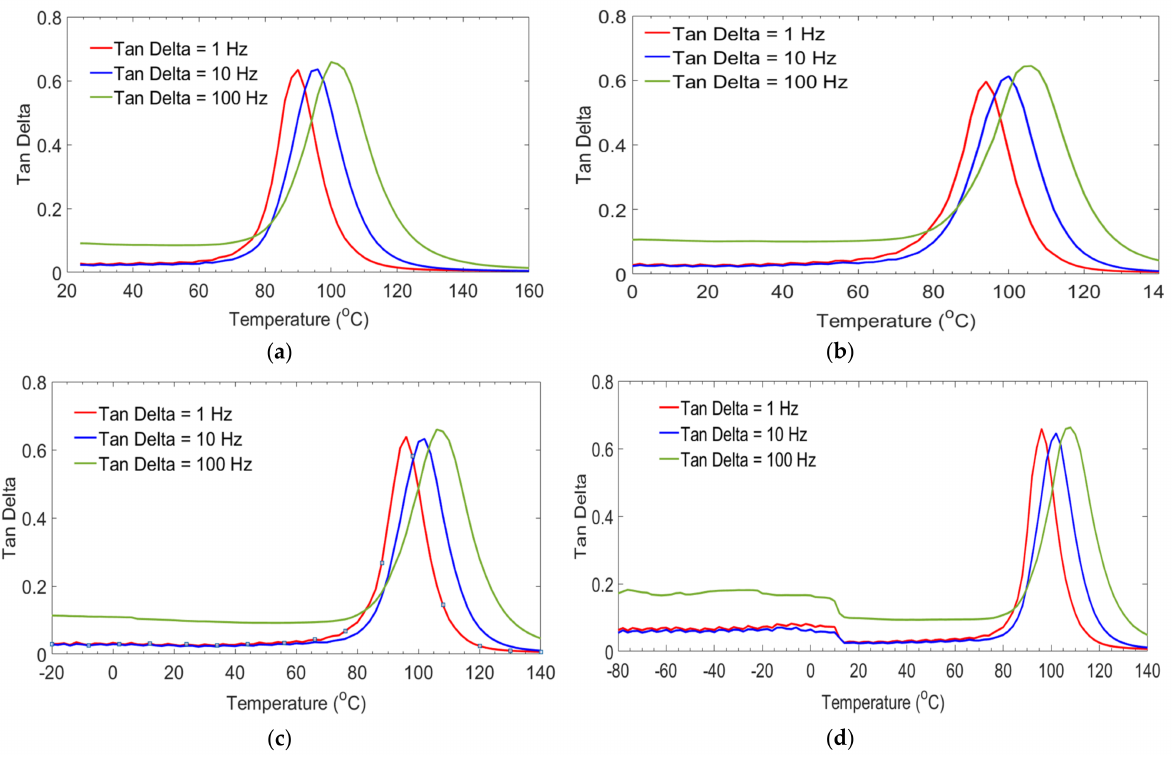
Figure 8. Damping factor with temperature of GE control ( a ), 0/G ( b ), − 20/G ( c ), − 80/G ( d )